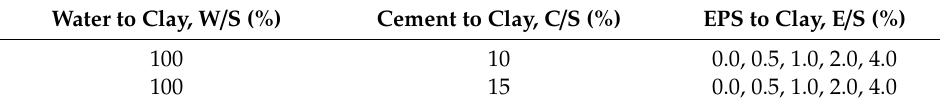
Table 2. Component ratios to dry clay by mass in EPS-cement lightweight clay. Water to Clay, W / S (%)